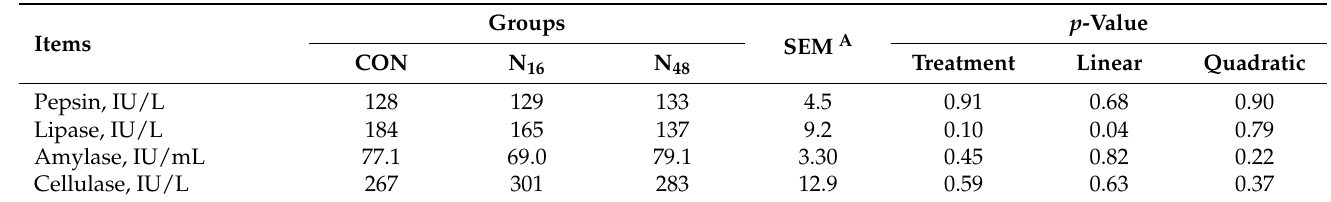
Table 5. Effects of the fruit of Nitraria tangutorum (FNT) supplement on rumen enzyme concentrations in Hu rams.